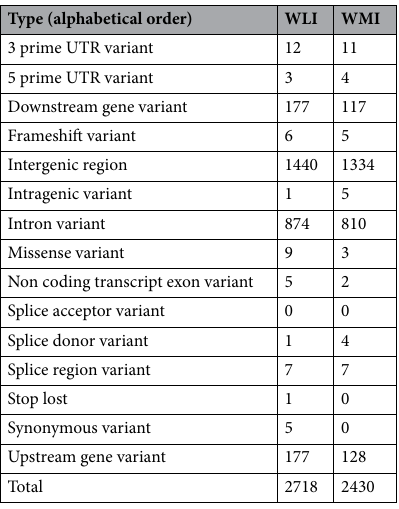
Table 2. Position of selected variants in regions of